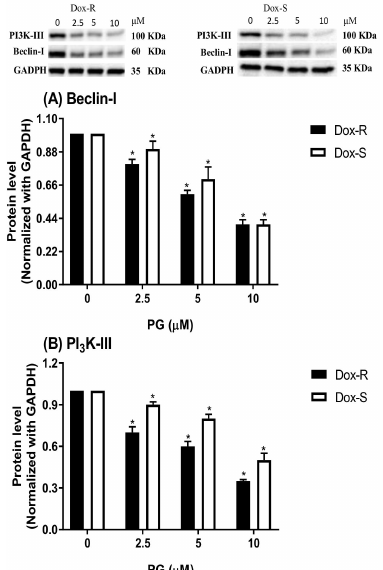
Figure 6. Alteration of autophagic inducer levels in Dox-R and Dox-S cells after PG treatment. ( A ) Beclin-1 and ( B ) PI3K-III were measured by Western blotting and normalized with GAPDH. Results were represented as mean ± SD from 3 independent experiments. *, p < 0.05 compared with untreated